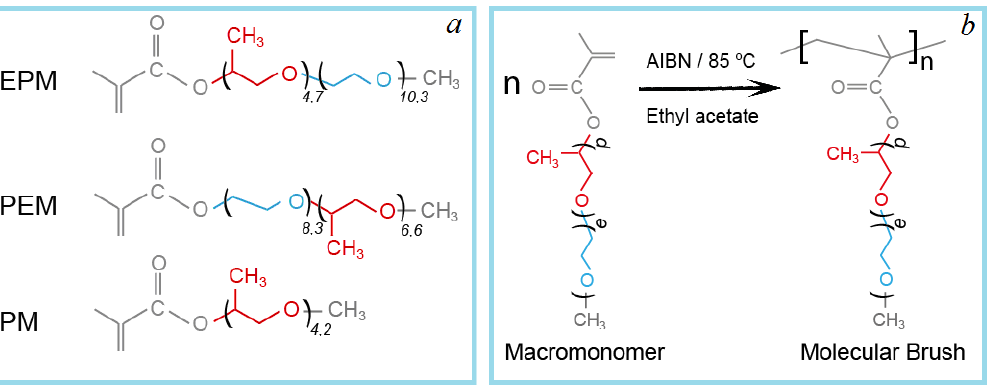
Figure 1. Structures of the macromonomers ( a ) and the scheme of polymerization ( b